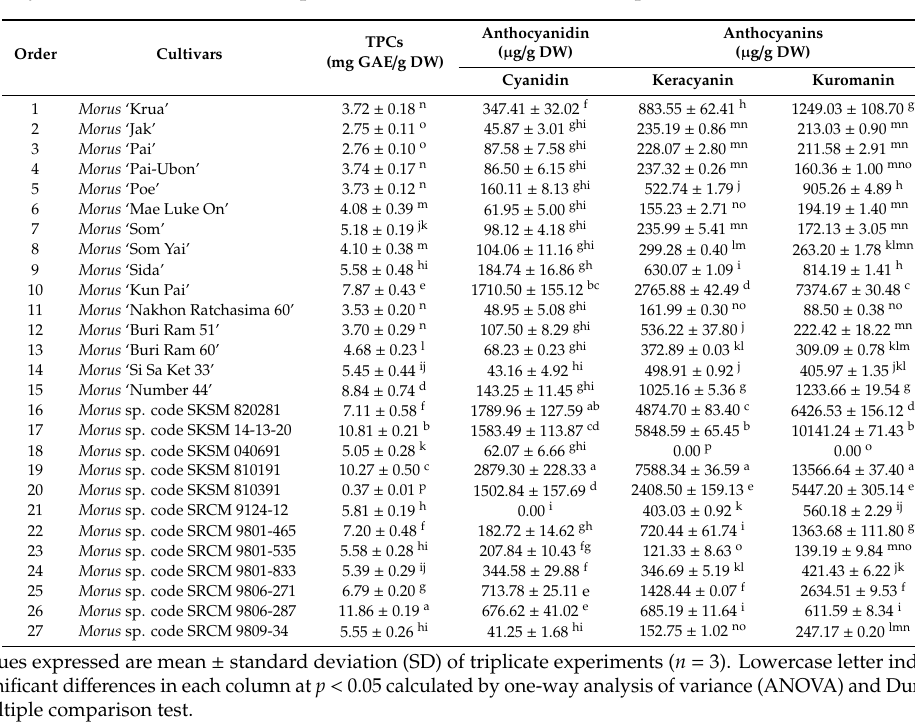
Table 1. Quantification of total phenolic contents (TPCs), anthocyanidin (cyanidin) and anthocyanins (keracyanin and kuromanin) of aqueous extracts of Morus fruit samples.